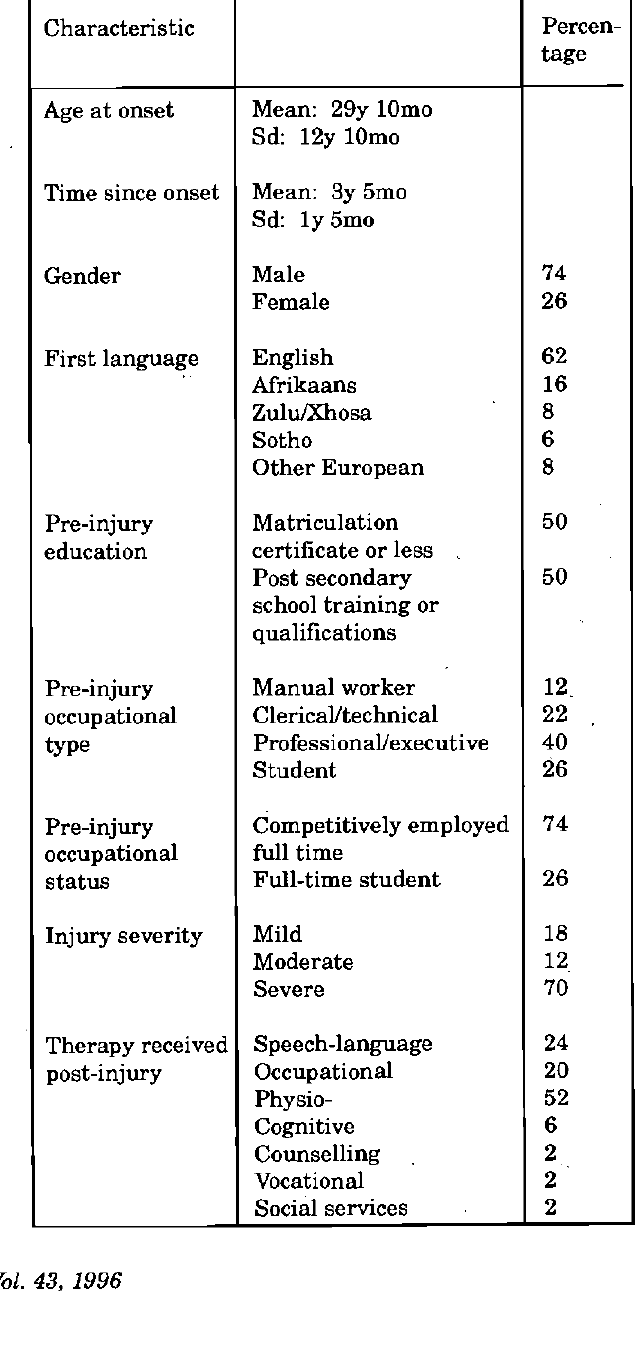
TABLE 1: Characteristics of the